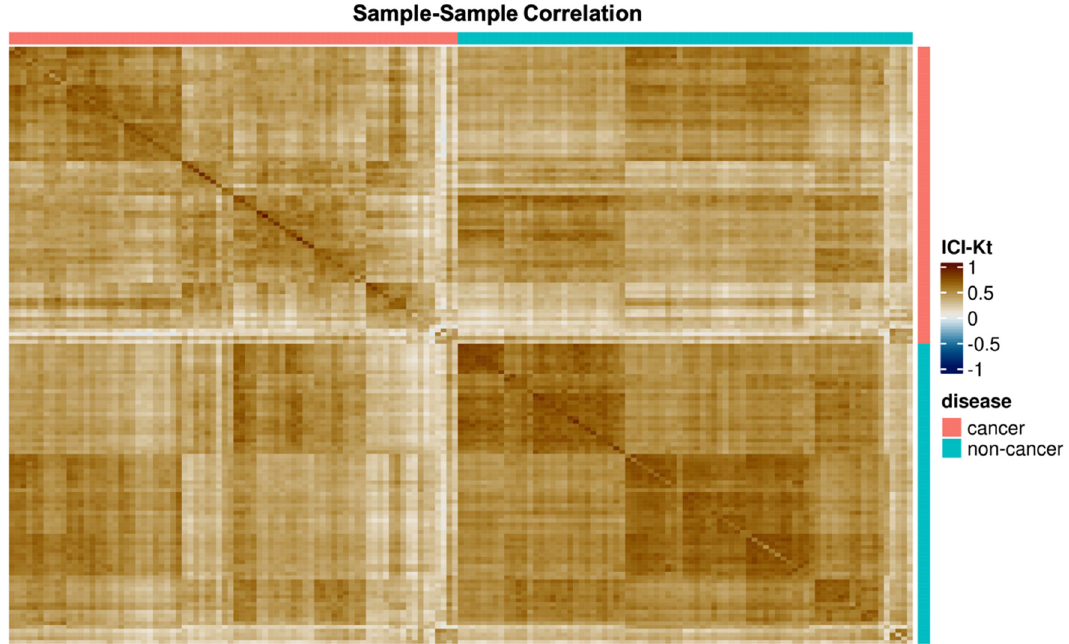
Figure 2. Correlation heatmap by disease. In general, samples belonging to the same disease class correlate more strongly with other samples in the same disease class. Stronger correlation patterns are observed within the non-cancer samples as compared to the cancer samples. In both cancer and non-cancer samples, there are multiple subgroups of samples that correlate more strongly with one another as well as occasional samples that have poor correlation with any other sample.